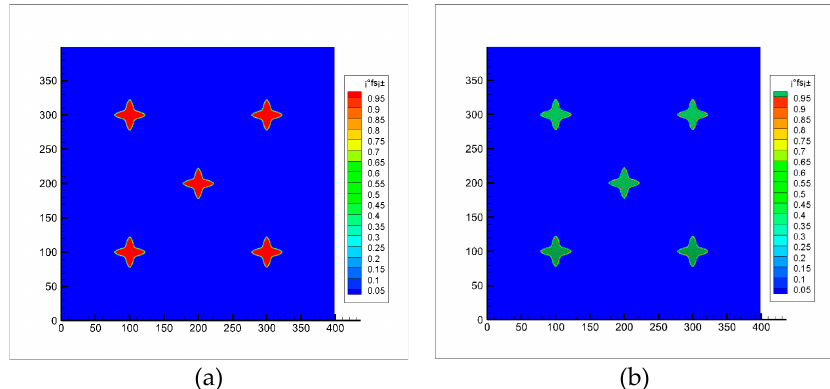
Figure 5. Dendritic morphology before and after rotation ( a ) Before rotation; ( b ) After rotation